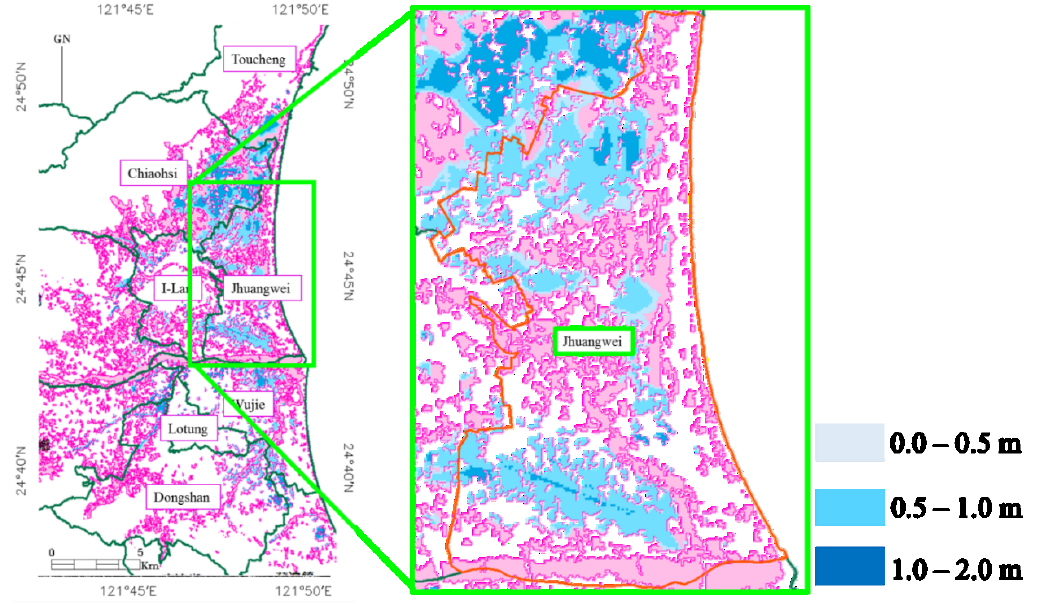
Figure 13. The flood depth map derived in this